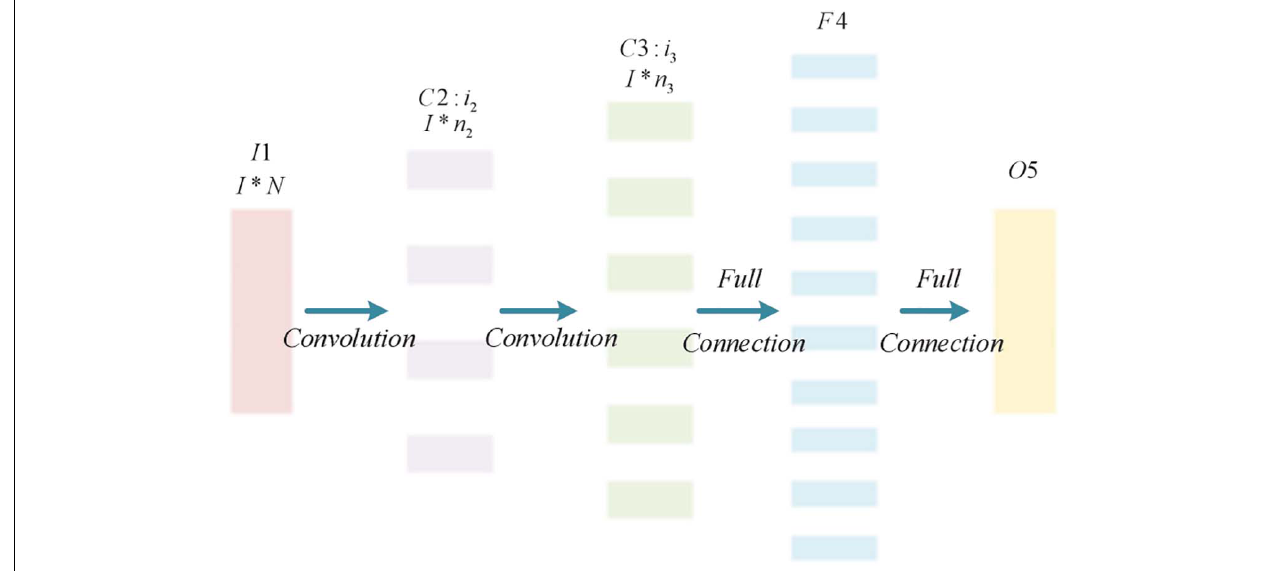
FIGURE 4 | Improved CNN network structure.